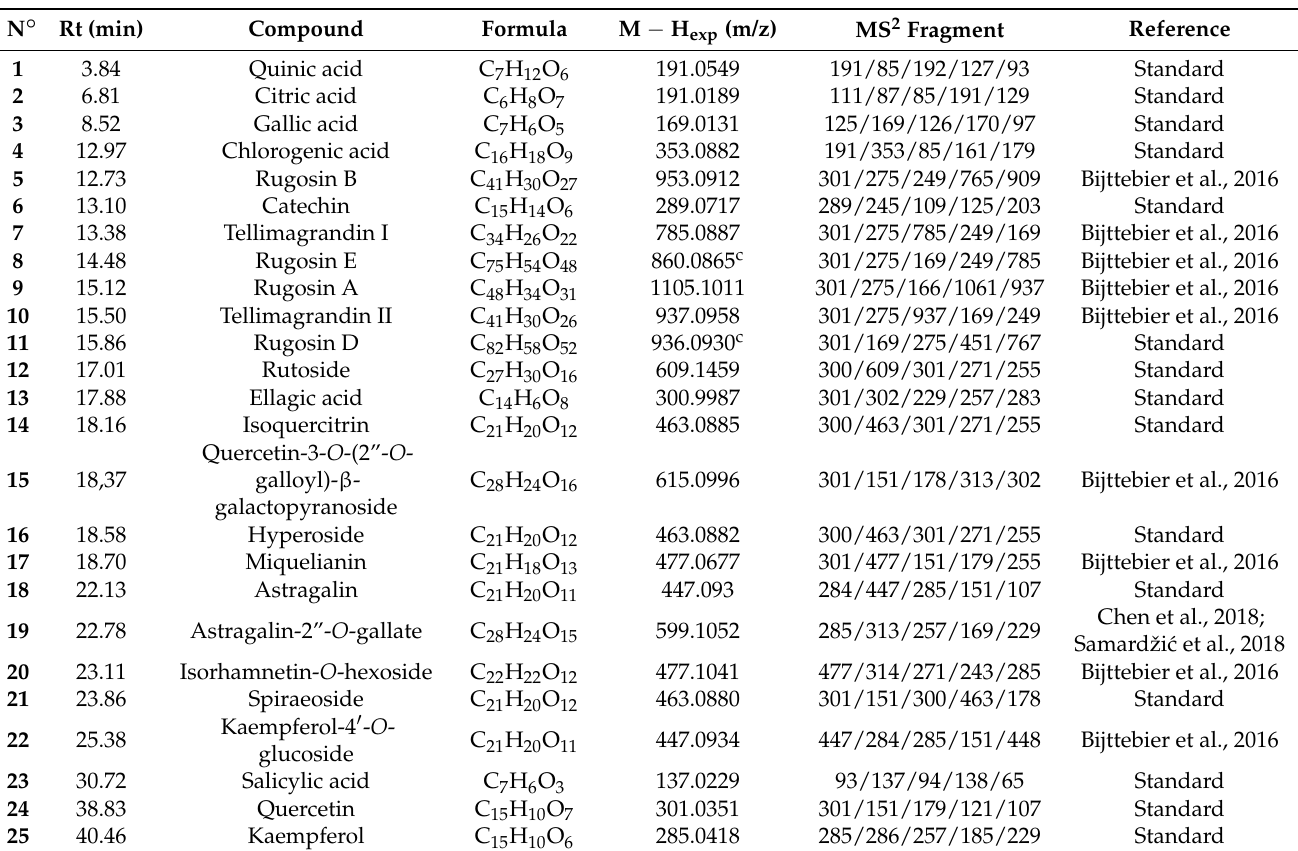
Figure 1. Chromatogram with compounds identified in F. ulmaria aerial parts. Table 1. Compounds identified in F. ulmaria aerial part extract.